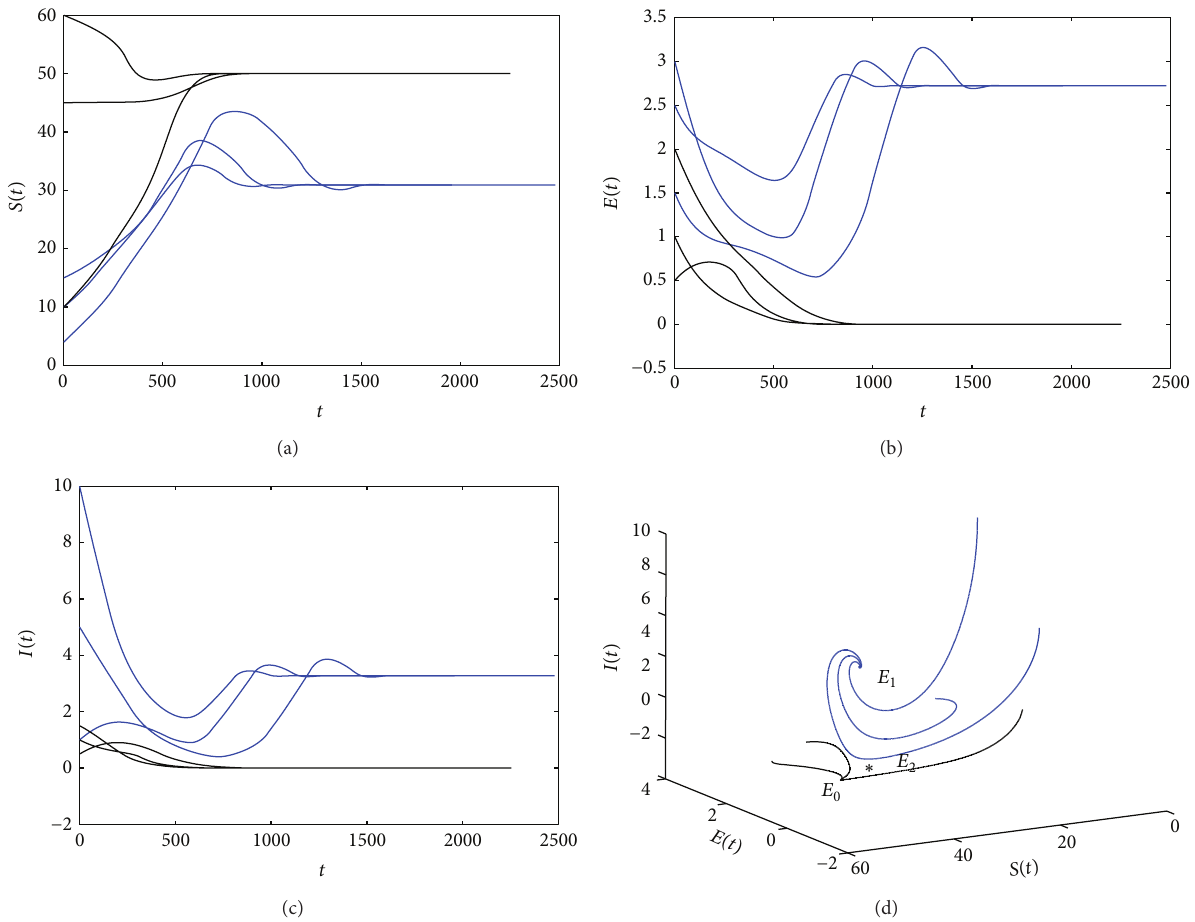
Figure 4: (a)–(d) show that system (7) has the bistable equilibria: a disease-free equilibrium 𝐸 0 (50, 0, 0) and an endemic equilibrium (30.9324582801, 2.7239504131, 3.2726743508) . And the other endemic equilibrium 𝐸 𝐸 1 unstable. In this case, 𝐴 = 10 , 𝛽 = 0.05 , 𝜀 = 1.2 , 𝑑 = 0.2 , 𝜇 = 0.2 , 𝜐 = 0.4 , 𝑟 = 1.5 , 𝛼 = 0.1 , and 𝑘 = 2